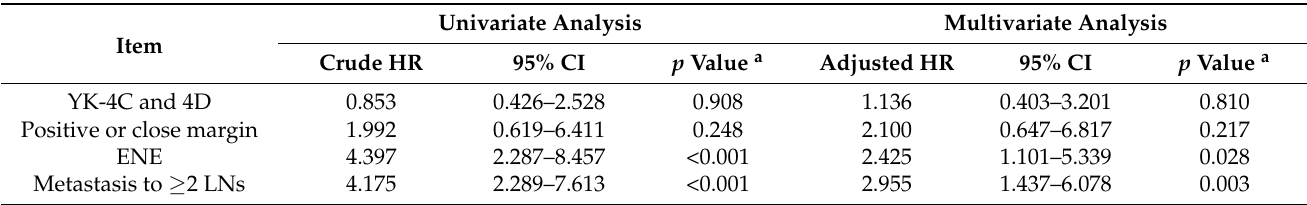
Table 3. Postsurgical events of patients with OSCC with major risk factors after surgical treatment ( n = 324). Item